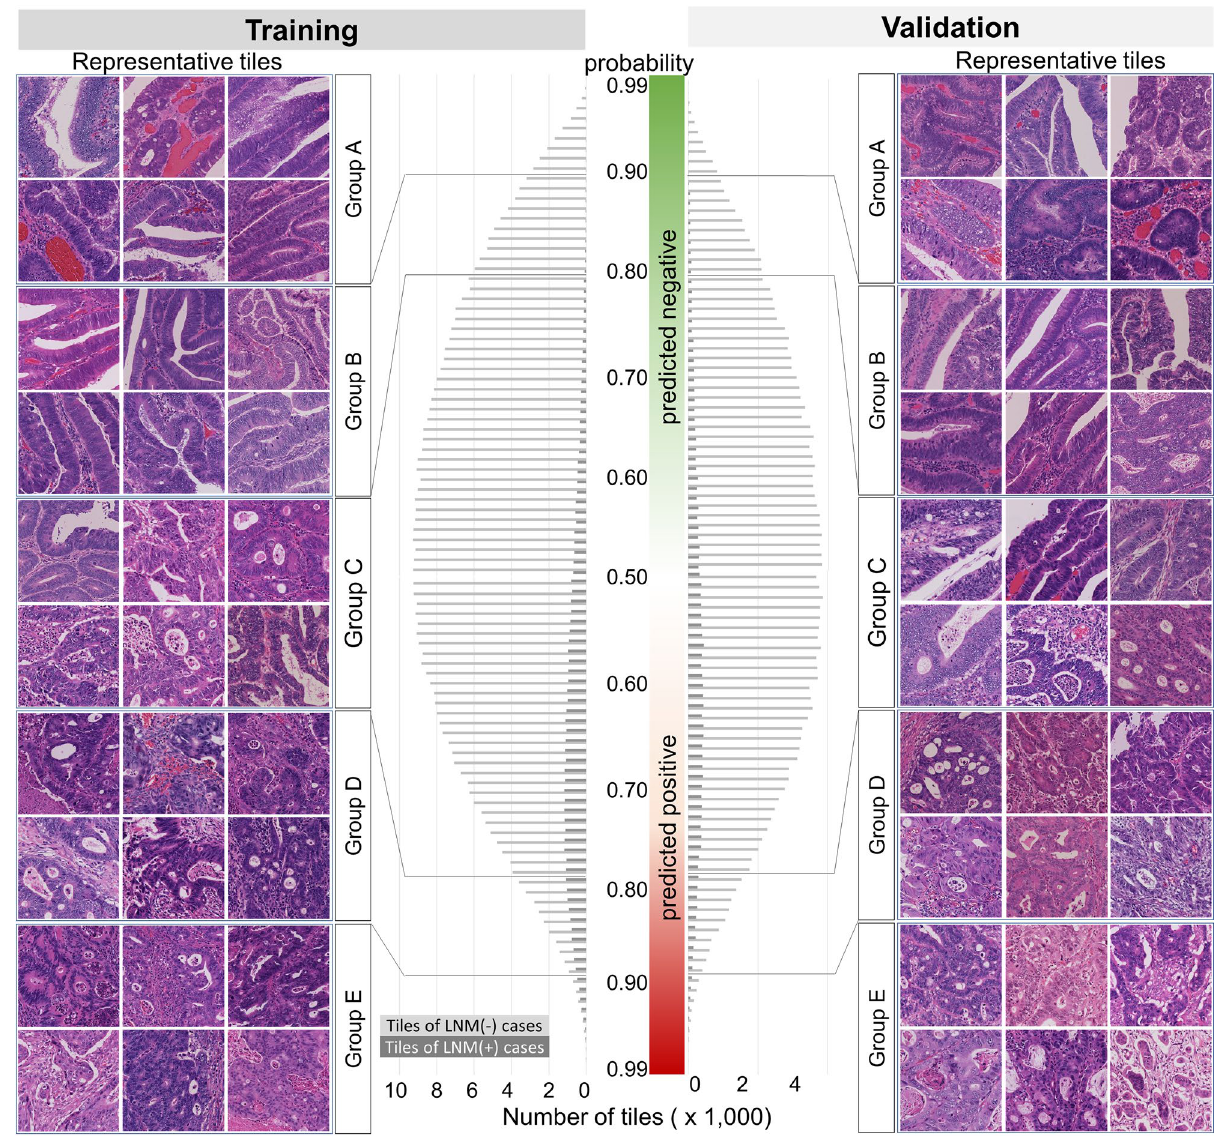
Figure 1. The profiles of tile images in the training and validation datasets. Bars indicate the number of tiles for each probability rank. Representative tile images of the training set are shown on the left side, and those of the validation set are shown on the right side. Note the differences of histologic grade among the groups, which the tile images in Group A show well differentiated tubular adenocarcinoma, while those in Group E contain poorly differentiated cancer cell clusters with desmoplastic stroma. LNM, lymph node